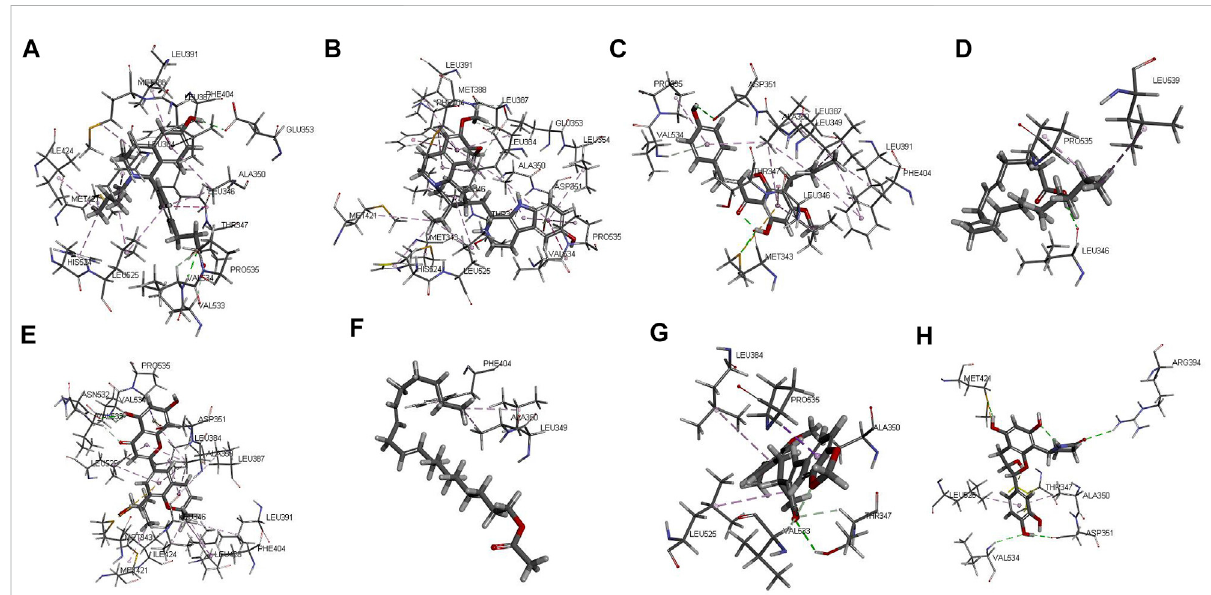
FIGURE 7 The 3D interaction of the original ligand GQD (A) , marckine (B) , xanthogalenol (C) , arachidonate (D) and yinyanghuo A (E) , linoleyl acetate (F) , suchilactone (G) and davallioside A_qt (H) with